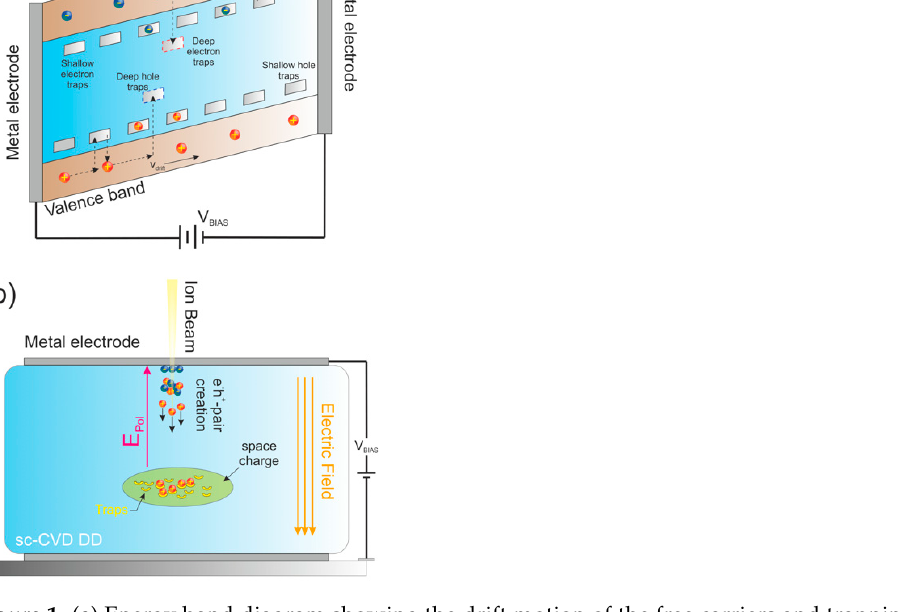
Figure 1. ( a ) Energy band diagram showing the drift motion of the free carriers and trapping/de- trapping process under the presence of an electric field; ( b ) diagram of the polarization